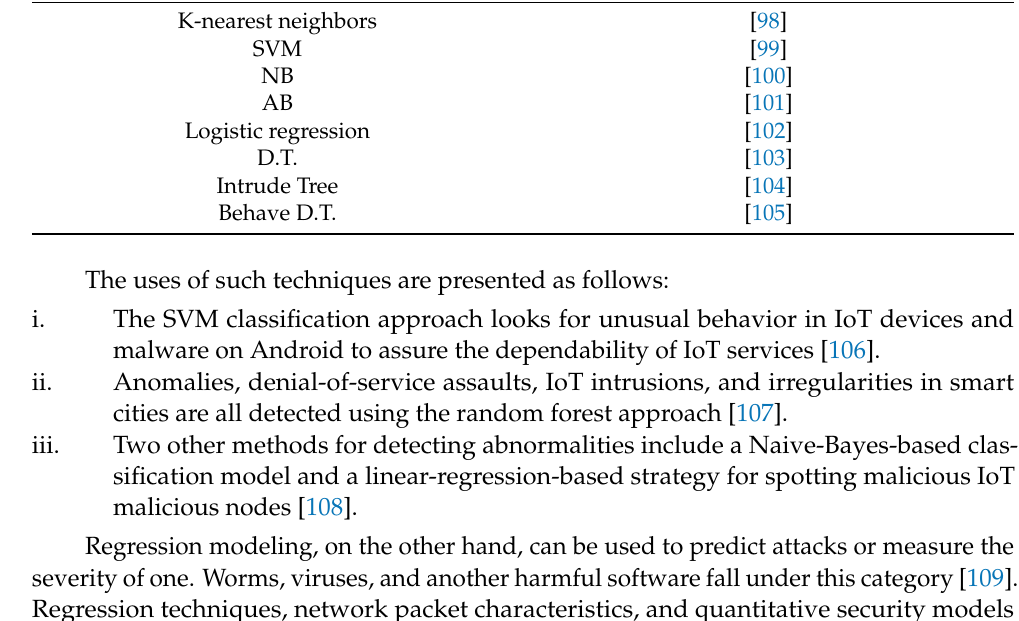
Table 10. Some ML techniques to handle various IoT security concerns.